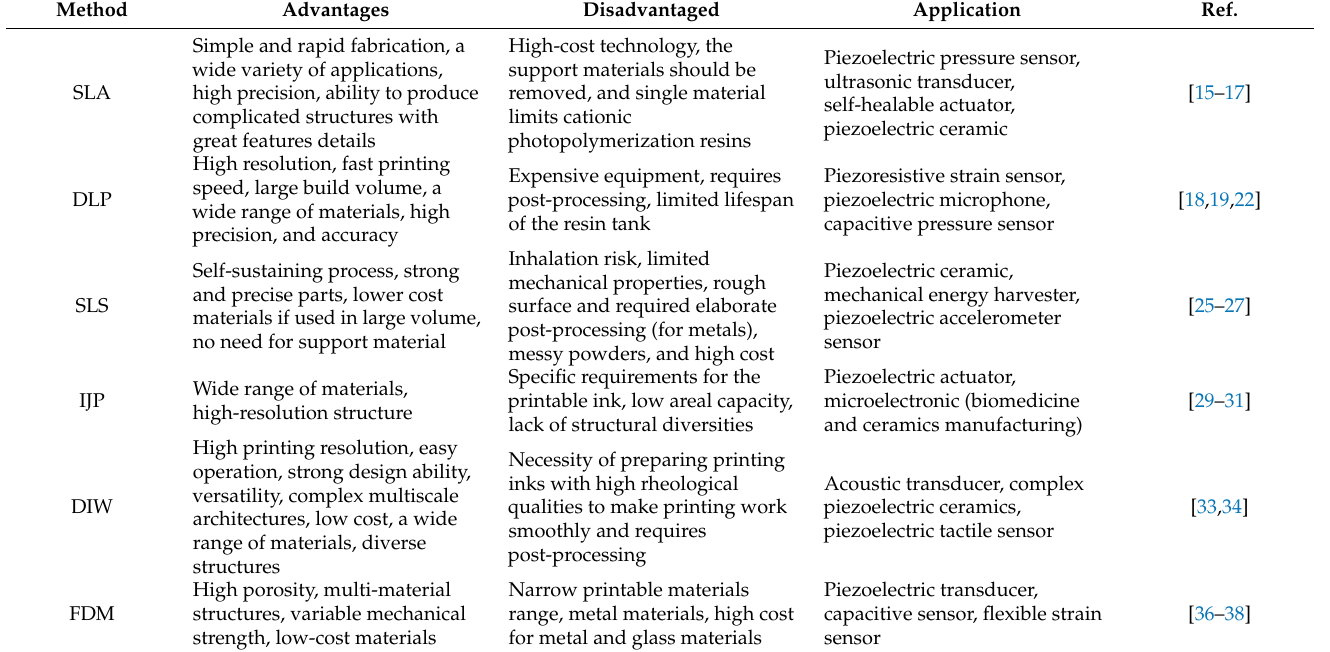
Table 2. Advantages, disadvantages, and applications of the most used 3D printing